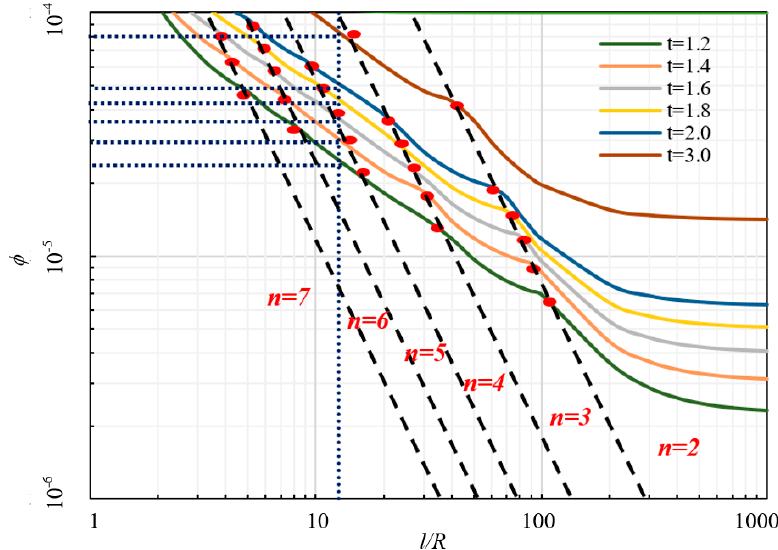
Figure 17. Critical pressure envelope under different wall